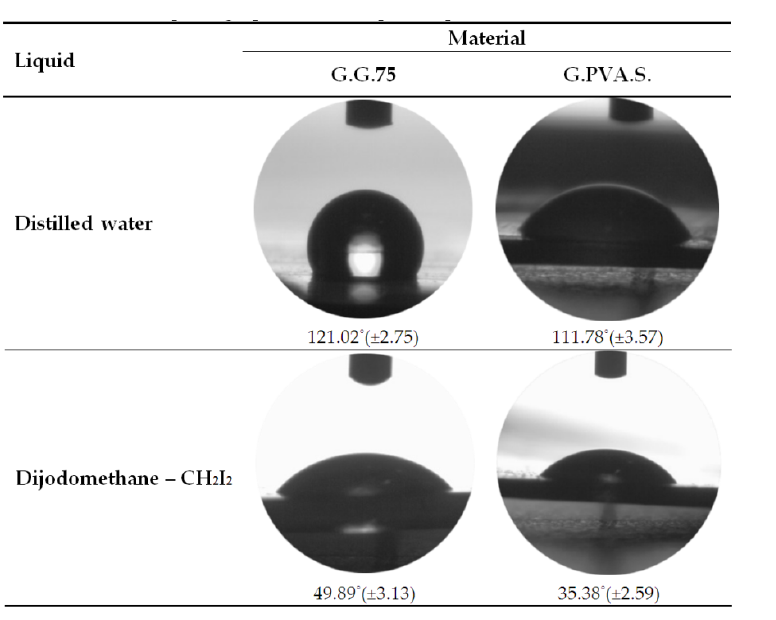
Figure 11. Photographs of water drops and diiodomethane drops on composites: G.G.75, G.PVA.S.